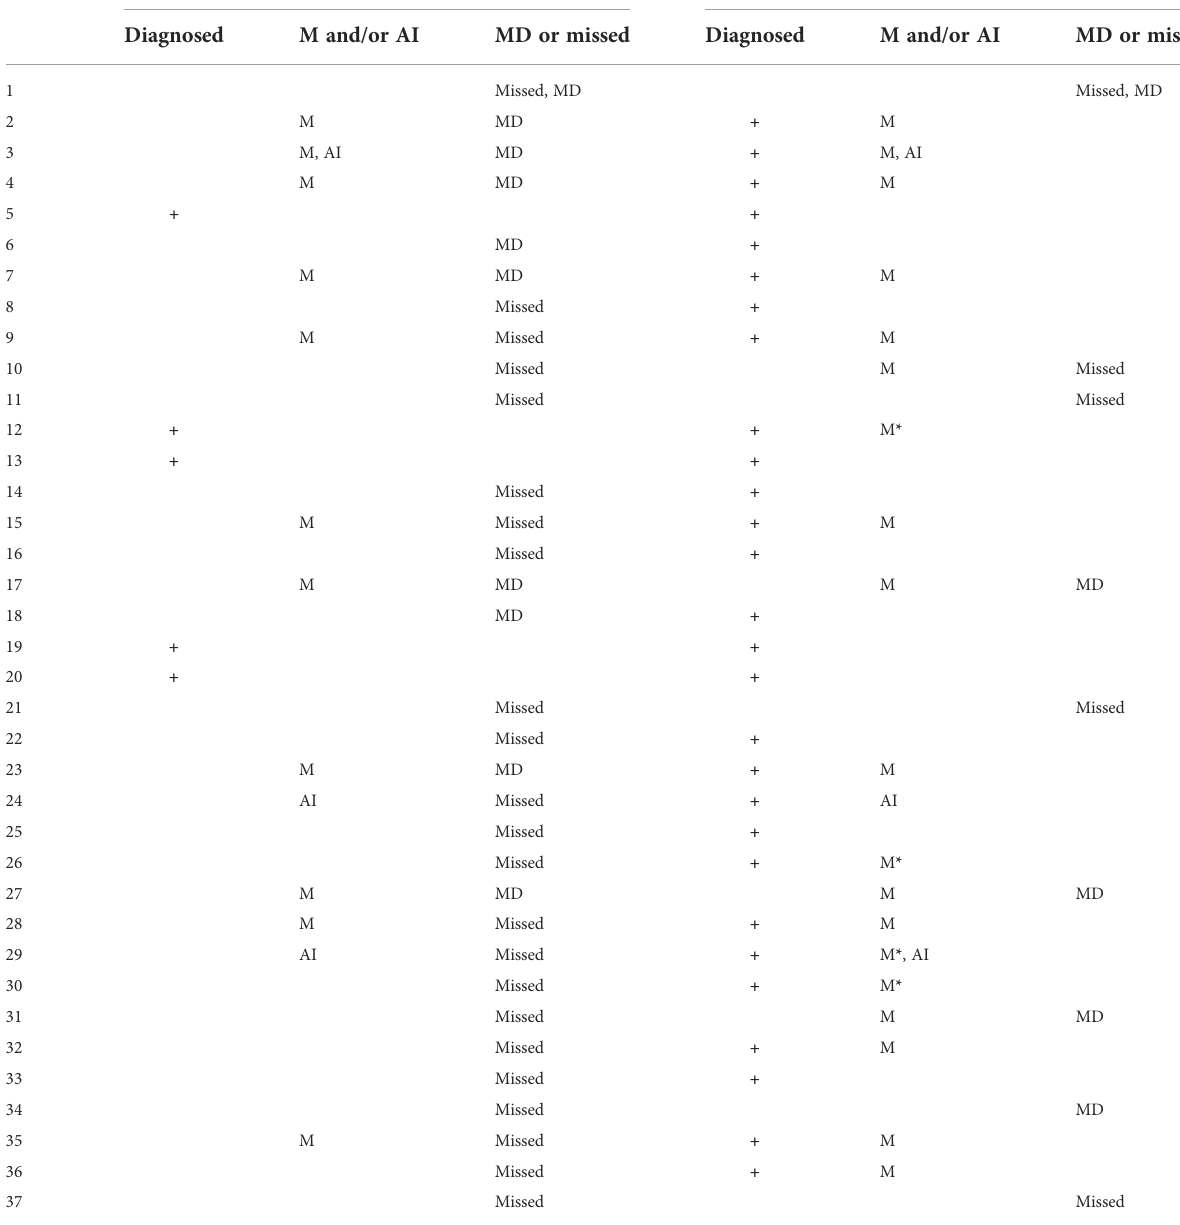
TABLE 3 Diagnostic performance for synchronous multiple primary malignant neoplasms occurring at the same time (SMPMNS): 18 F- fl uorodeoxyglucose positron emission tomography/computed tomography ( 18 F-FDG PET/CT) vs. conventional imaging. Case Conventional imaging prior to